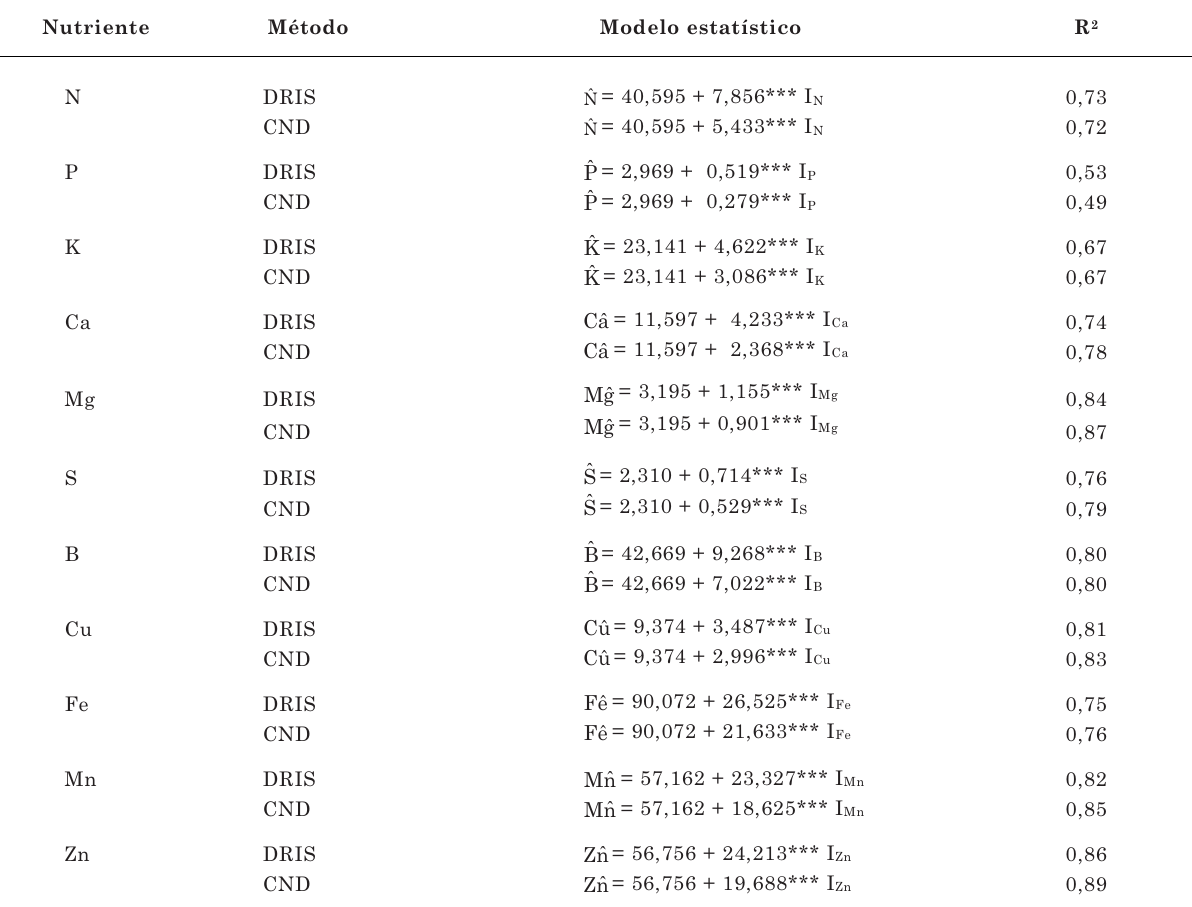
Quadro 2. Modelos estatísticos dos relacionamentos entre teores de nutrientes e índices DRIS (1) e CND (2)